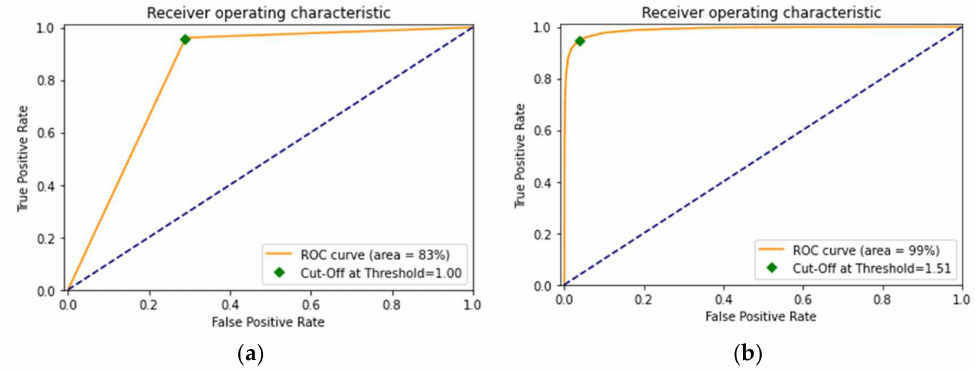
Figure 14. ( a ) Receiver operator characteristic (ROC) curve before fine-tuning ( b ) ROC curve after